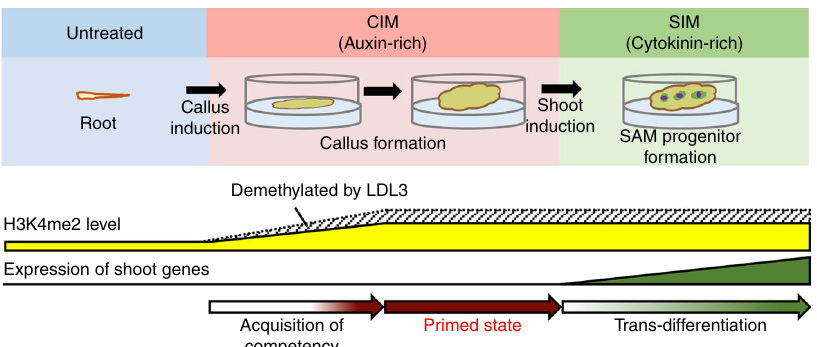
Fig. 8 Schematic of the acquisition of shoot regenerative competency. LDL3 is up-regulated and erases H3K4me2 marks of downstream genes during callus formation, although the total amount of H3K4me2 is still increased. The removal of H3K4me2 mediated by LDL3 does not immediately alter the gene expression of callus tissue, but is primed for subsequent shoot induction, which allows the genes for shoot initiation to be activated. The shaded area indicates the H3K4me2 removed by LDL3 during